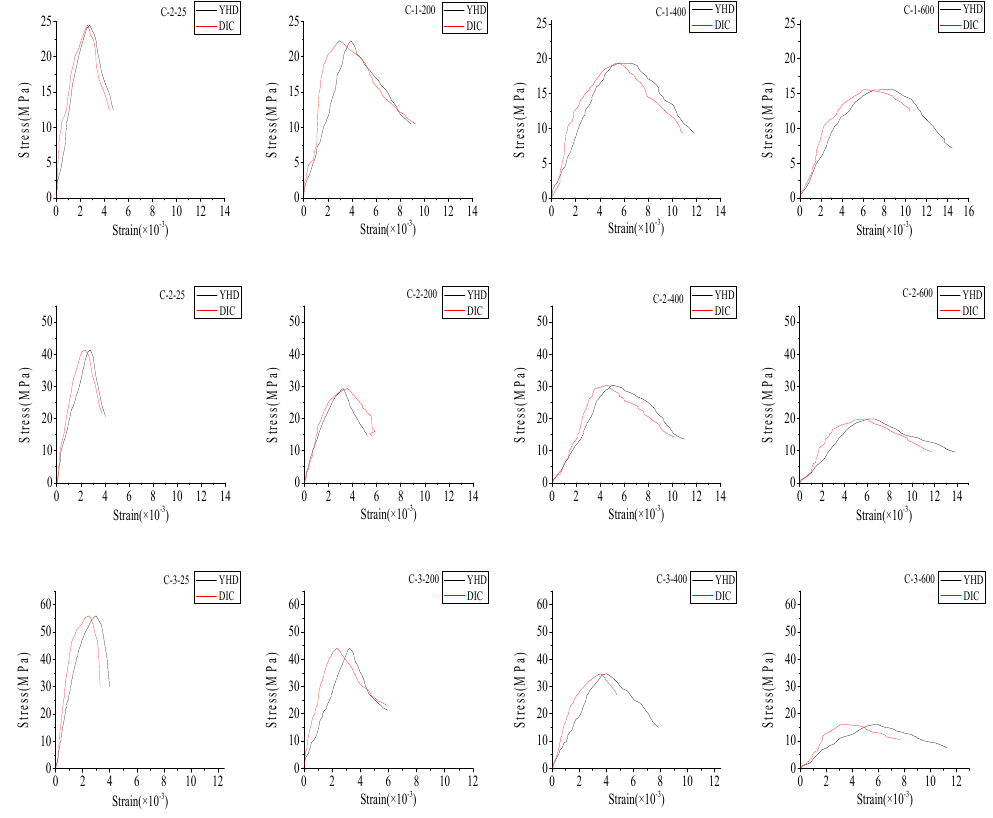
Figure 8. Stress–strain curves of specimens at different temperatures.